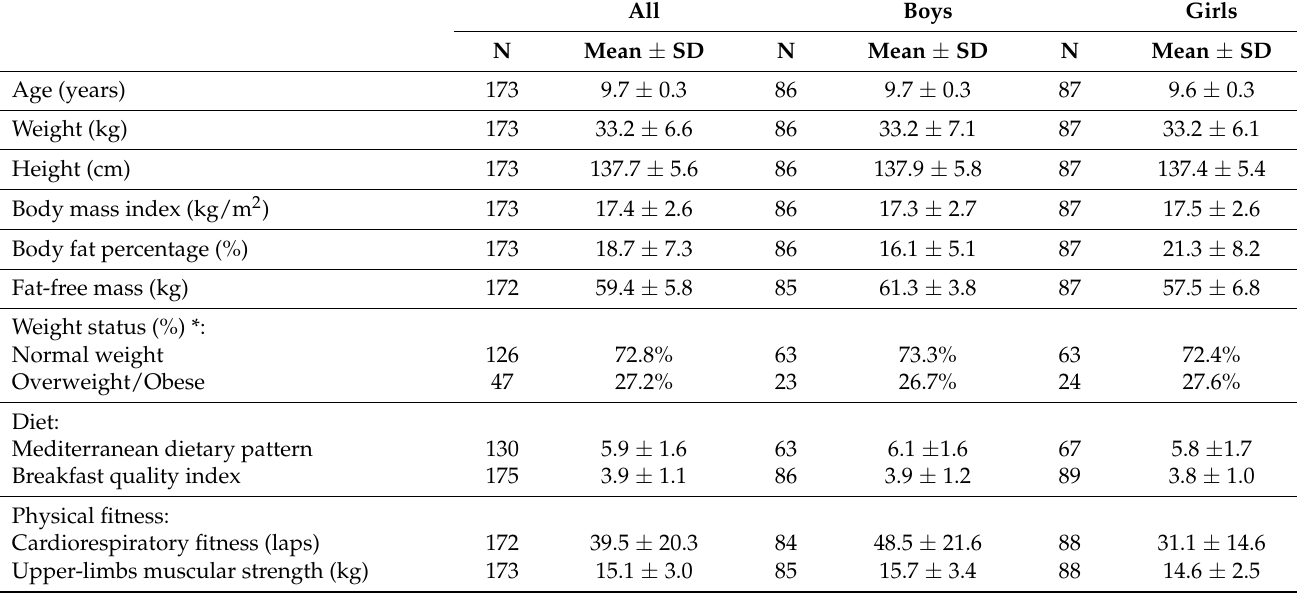
Table 1. Descriptive characteristics of the study